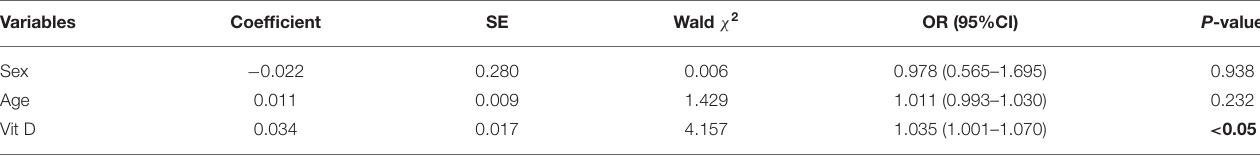
TABLE 3 | Risk of TB and Vitamin D in the Han population by logistic regression analysis.